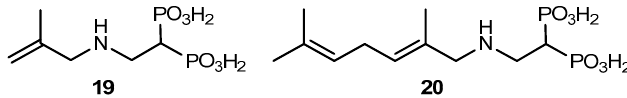
Figure 3. Chemical structures of the designed target molecules based on crystallographic and molecular modeling studies.